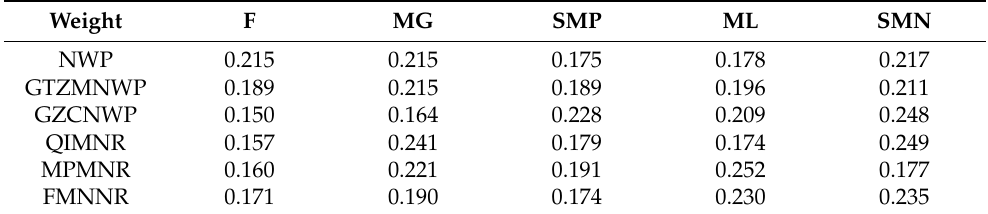
Table 6. The weight of each index of nature